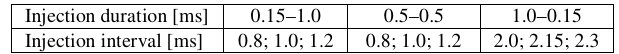
Table 2. Test matrix for split injection